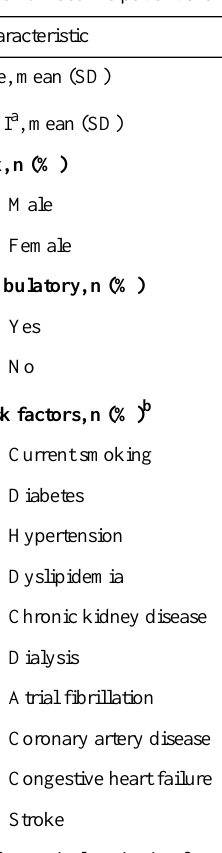
Table 1. Baseline patient